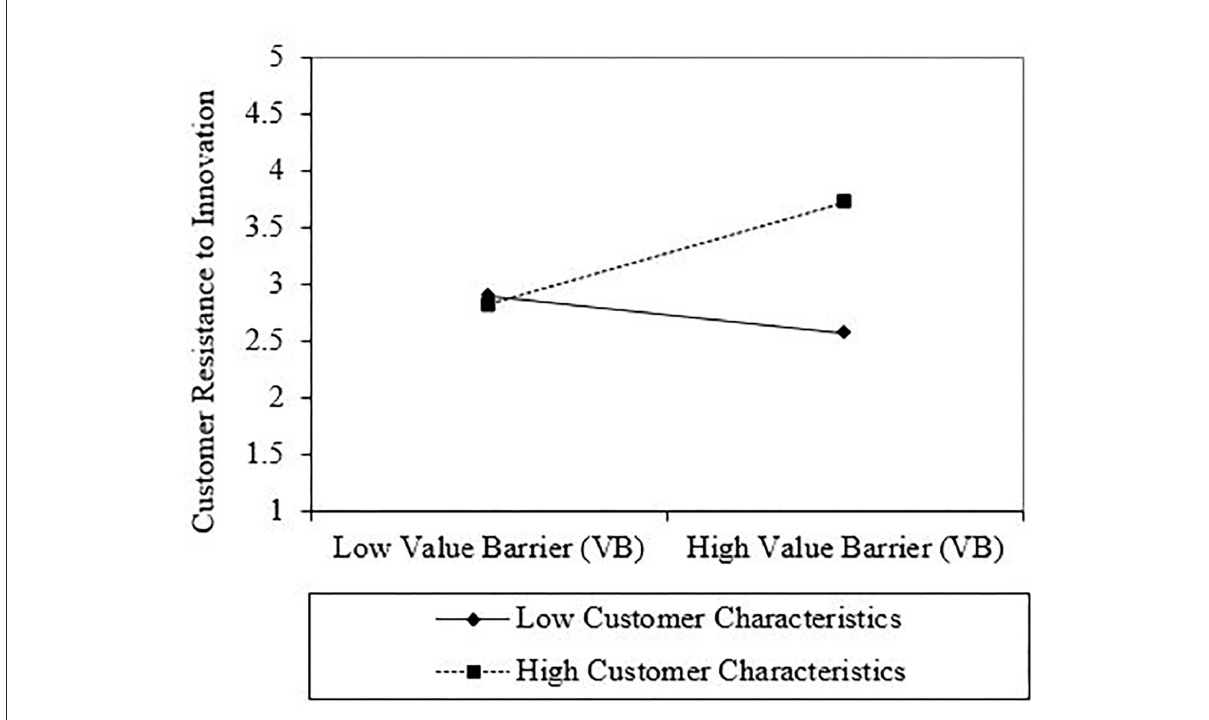
FIGURE2 Interaction plot of value barrier (VB) and customer characteristics interaction on the customer resistance to